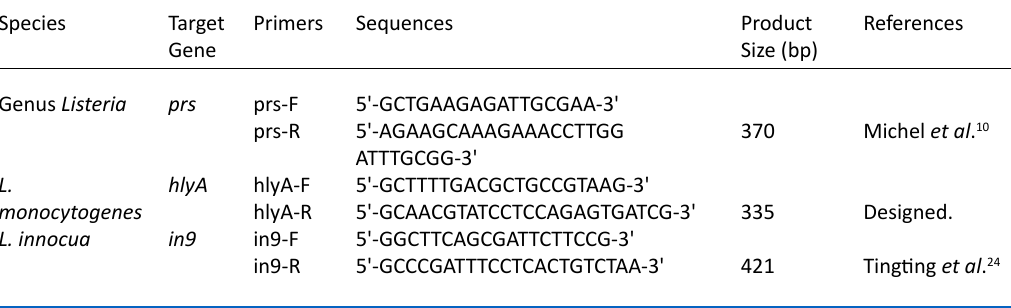
Table 1. Primers used for identification of Listeria species